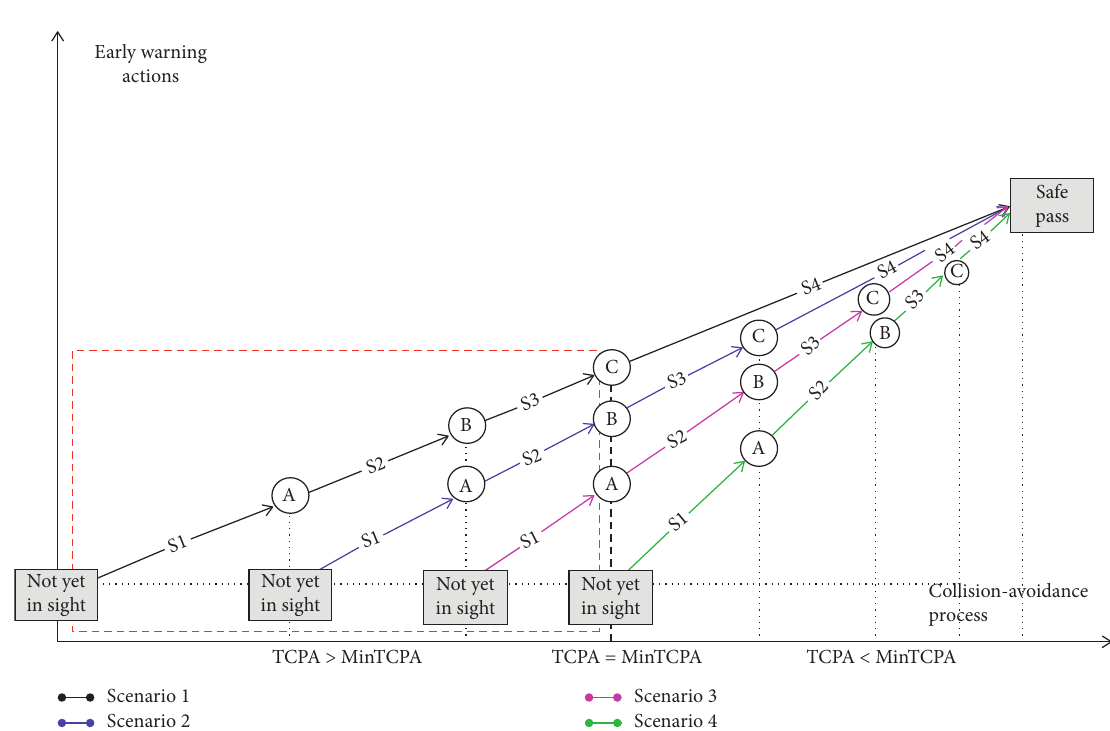
Figure 5: Coordinated avoidance actions of two ships with early warning. A: understanding each other’s movements. B: unifying collision- avoidance strategies. C: taking coordinated maneuvering actions. S1: not yet understanding each other’s movements. S2: not yet unifying collision-avoidance strategies. S3: not yet taking coordinated maneuver’s actions. S4: verifying collision-avoidance effectiveness. TCPA: time to the closest point of approach.